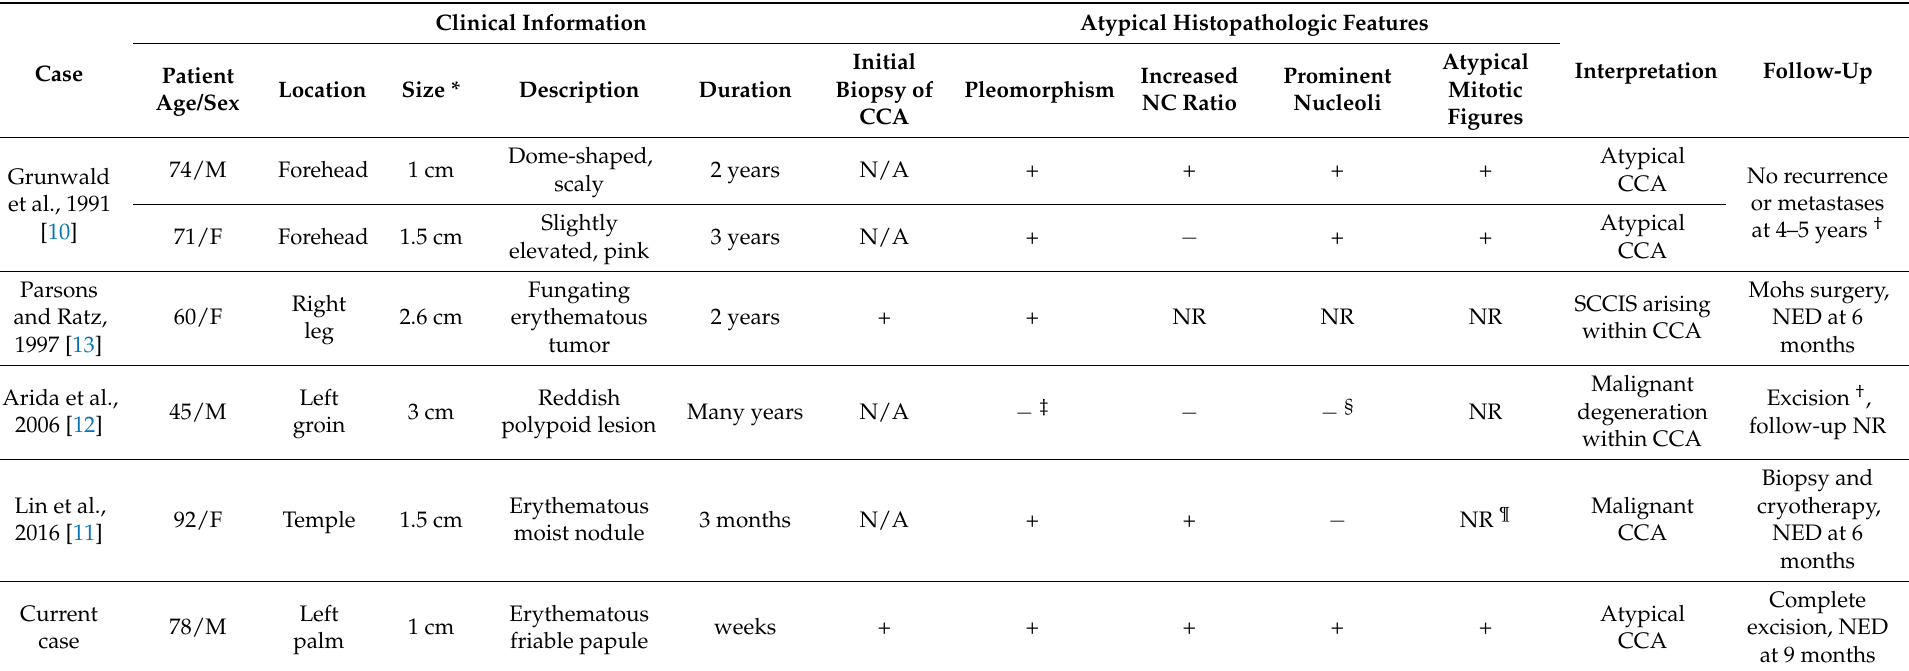
Table 1. Summary of previously reported cases of CCA with malignant